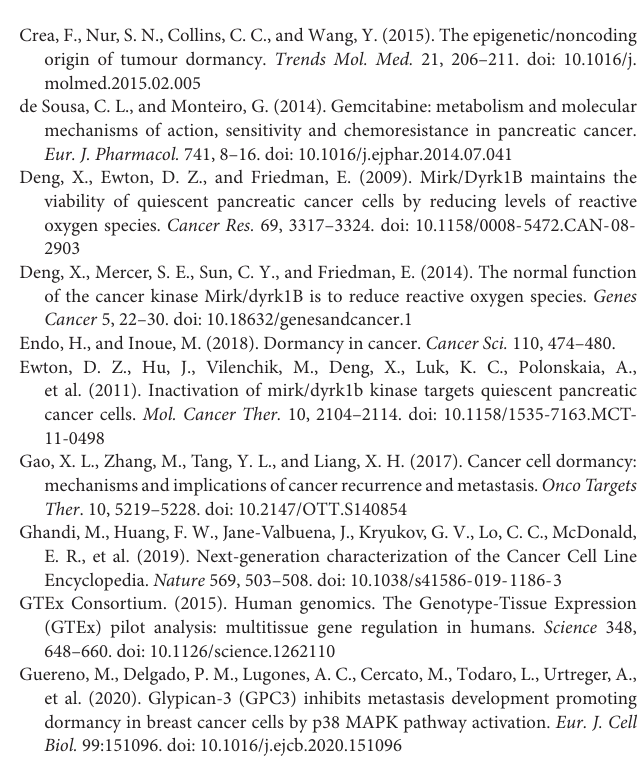
Supplementary Figure 1 | The expression levels of CIRBP in different pancreatic cancer cell lines and the immortal human pancreatic duct epithelial cell line (HPDE6-C7). (A) The protein expression of CIRBP were assessed by Western blot. (B) The mRNA expression of CIRBP were assessed by RT-qPCR. HPDE6-C7 was used as a control of pancreatic cancer cells. ∗ P < 0.05, ∗∗∗ P < 0.0001, one-way analysis of variance. Supplementary Figure 2 | The influence of CIRBP on migration of PDAC cells in vitro . (A) The effect of CIRBP knockdown on migration of PANC-1 (left) and SW1990 (right) cells. (B) The effect of CIRBP overexpression on migration of PANC-1 (left) and SW1990 (right) cells. All experiments were repeated three times. Data are presented as mean ± SD. ∗ P < 0.05, compared the relative wound residual area between the CIRBP sh#1 or sh#2 group and the shRNA-vector group, unpaired student’s t -test. Supplementary Figure 3 | The apoptotic analysis of PDAC cells treated with gemcitabine (Gem: PANC-1, 5 µ M; SW1990, 3 µ M) for 48 h. (A) PANC-1 cells were treated with gemcitabine at 5 µ M. (B) SW1990 cells were treated with gemcitabine at 3 µ M. Data are presented as mean ± SD. ∗ P < 0.05, ∗∗∗ P < 0.001, unpaired student’s t -test. Supplementary Figure 4 | AKT/mTOR pathway expression in the CIRBP-transfected PDAC cells. (A) Proteins in the AKT/mTOR pathway, including phosphorylated and total AKT, mTOR and p70S6K, were analyzed by Western blot in CIRBP overexpression PDAC cell lines. (B) Proteins in the AKT/mTOR pathway, including phosphorylated and total AKT, mTOR and p70S6K, were analyzed by Western blot in CIRBP knockdown PDAC cell lines. β -actin was used as a loading